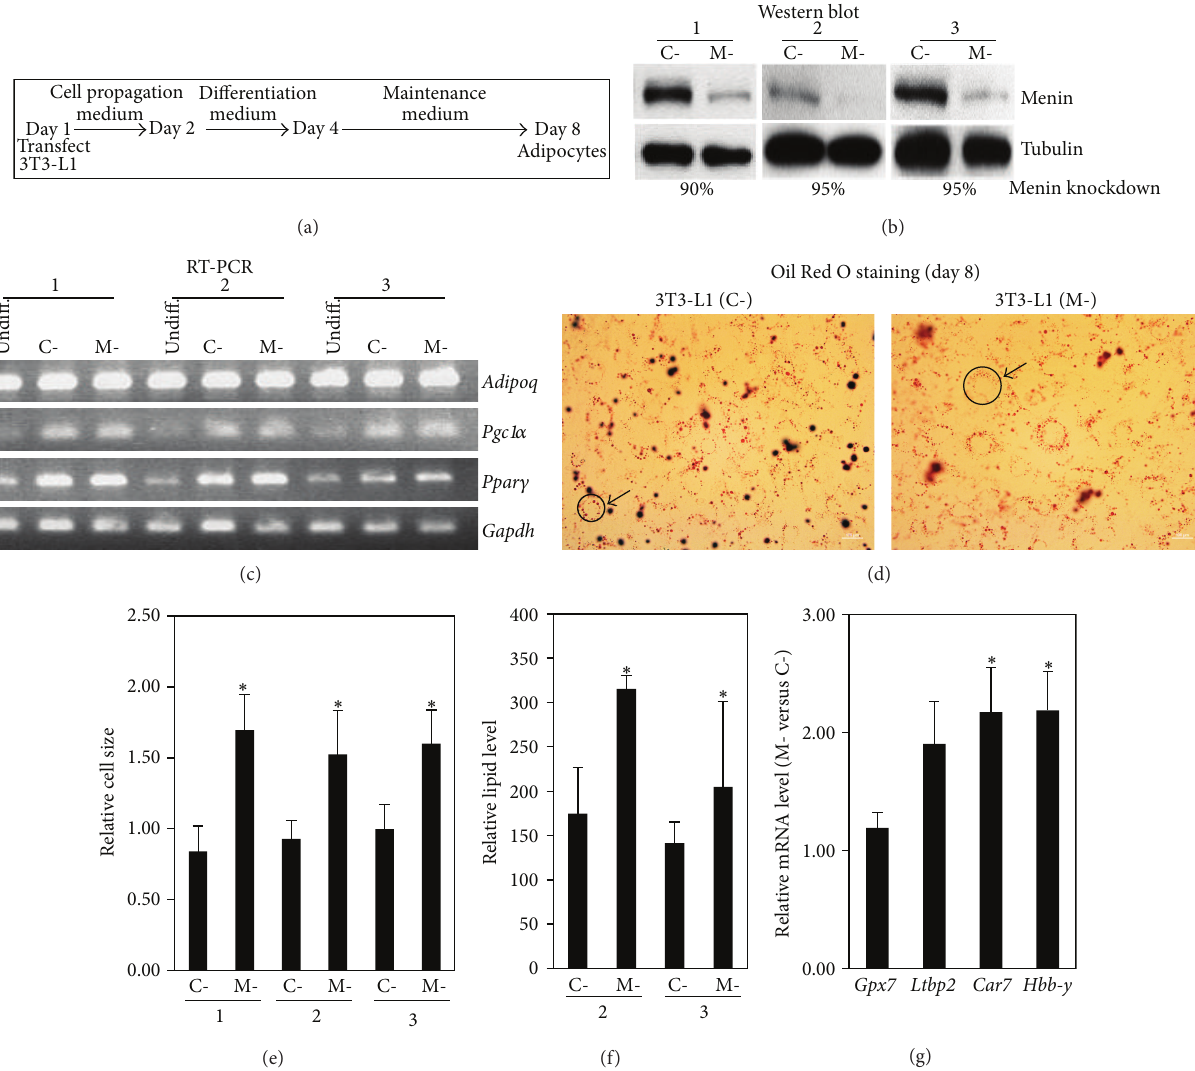
Figure 3: 3T3-L1 cells with menin knockdown can also undergo in vitro differentiation into adipocytes and show increased adipocyte cell size. (a) In vitro adipogenesis. Control shRNA plasmid (C-) or Men1 shRNA plasmid (M-) transfected 3T3-L1 cells were plated on day 1 in 3T3-L1 cell propagation medium overnight. The medium was replaced with differentiation medium for 2 days, followed by maintenance medium for 4 days to produce adipocytes, with a medium change (maintenance medium) every two days. (b) Menin knockdown. Whole cell extracts prepared from 3T3-L1 cells differentiated as shown in (a) were analyzed for the level of menin knockdown by western blot (day 8 adipocytes). Antitubulin was used as the loading control. Percent knockdown of menin was calculated after normalization to tubulin. Data are shown for 3 independent experiments. (c) Expression of adipocyte marker genes. RNA isolated from the 3 independent experiments shown in (b) was analyzed for the indicated adipocyte marker genes ( Adiponectin , Pgc1 𝛼 , and Ppar 𝛾 ) and an internal control gene ( Gapdh ) by conventional RT-PCR followed by agarose gel electrophoresis. Lanes marked “undiff” are 3T3-L1 cells before in vitro differentiation. (d) Oil Red O staining. Bright-field microscopy images of C- and M- differentiated 3T3-L1 cells stained for lipids/triglycerides after adipogenesis by Oil Red O staining show round adipocyte cells with lipid droplets (orange colored spots). Images are shown for experiment 2. Magnification = 400x. (e) Relative cell size. Cell diameter was measured as an index of cell size from 3 to 5 microscopy fields using the cell outline formed by the circle of orange lipid droplets accumulated inside the round adipocytes from the 3 independent 3T3-L1 differentiation experiments performed in (b) (an example marked with a black circle and arrow is shown in (d)). Diameter mean and SD are shown ( ∗ 𝑝 < 0.05 ). Note: the units on the 𝑌 -axis do not reflect the actual diameter of the cells but they reflect the measurement of the cell diameter from images captured at 400x magnification. (f) Relative lipid content. After adipogenesis, Oil Red O staining for lipids/triglycerides was performed, dye was extracted, and the OD was measured at 520 nm. Relative lipid level is shown for 2 independent experiments performed in (b) (OD at 520 nm). Error bar = SD. ∗ 𝑝 < 0.05 . (g) Relative expression of differentially expressed genes identified by microarray analysis of mESC-derived adipocytes. Genes more than 5-fold downregulated ( 𝑛 = 8 ) or upregulated ( 𝑛 = 12 ) in mESC-derived menin-null adipocytes were analyzed by QPCR using RNA isolated from adipocytes derived by in vitro differentiation of 3T3-L1 cells shown in (b) (experiment 2). QPCR relative fold change (normalized to Gapdh) is shown for 4 genes. The other 16 genes did not yield a PCR product in either cell type (C- or M-). ∗ 𝑝 < 0.05 ( > 2-fold change in M- versus